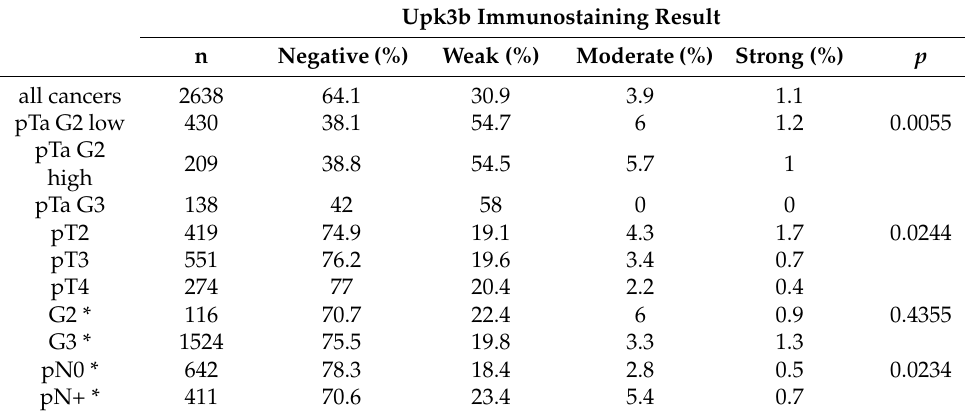
Table 2. Upk3b immunostaining and tumor phenotype.